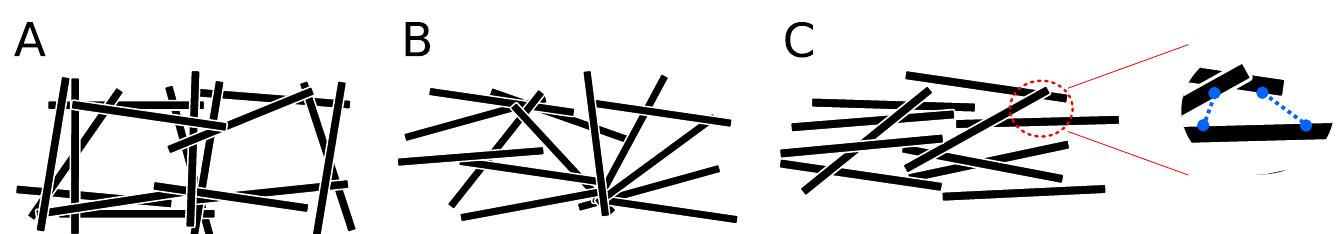
Fig 1. Typical actin organizations in one patch of the cortex. Actin structures are highly dynamic and reorganize in response to internal and external cues. These structures can be organized into an open meshwork of actin filaments (black, A), clusters or foci distributed throughout the cortex (B), or aligned bundles (C). Detail of a portion of the meshwork (right, C) shows filaments crosslinked by proteins such as the motor protein myosin (blue). These actin organizations are seen in a variety of cells, from plants to mammals.